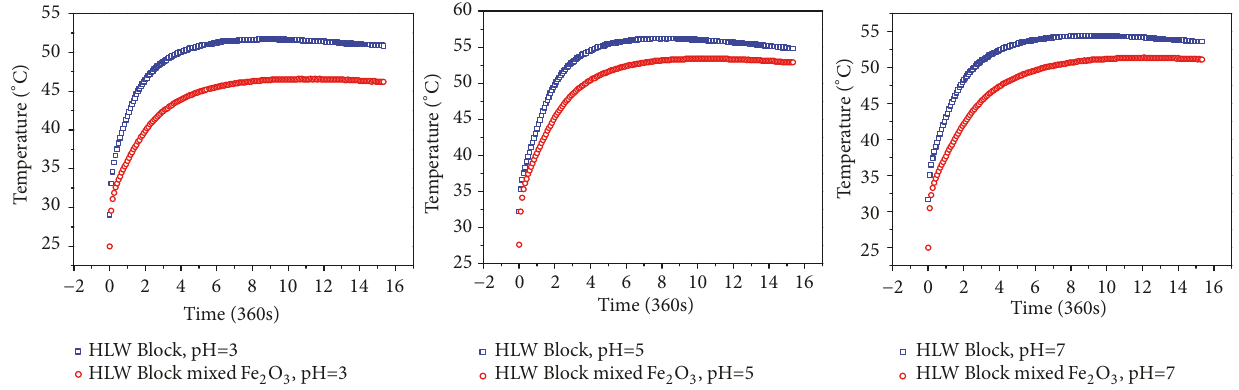
HLW Block, pH=3 HLW Block mixed ＆？ 2 ／ 3 , pH=3